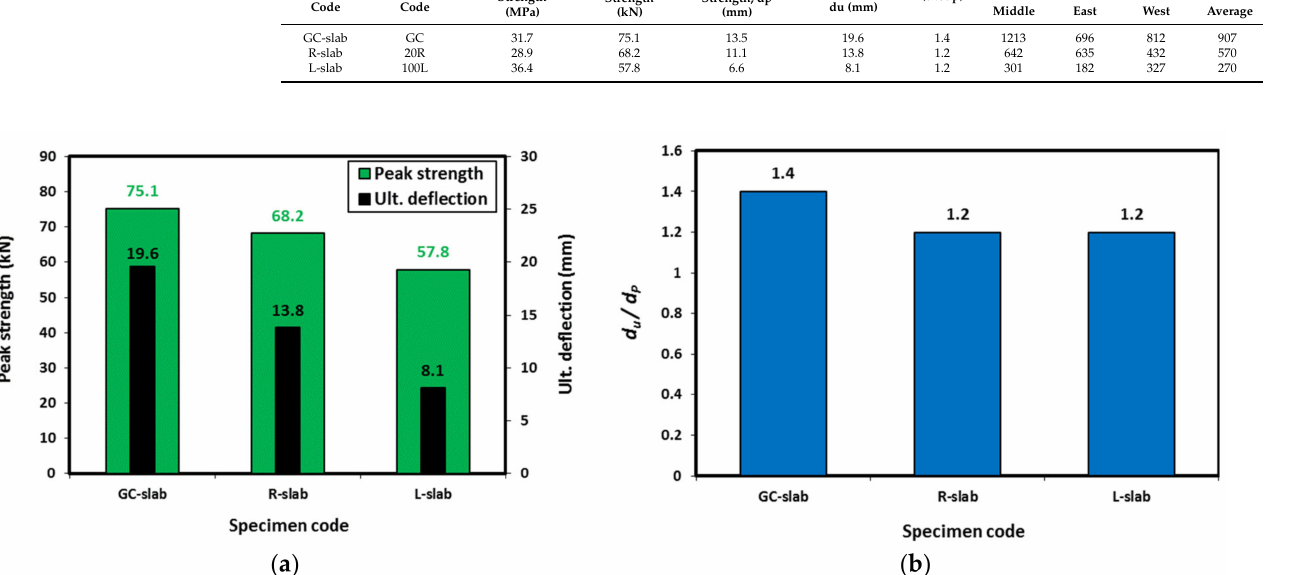
Figure 12. Results of the tested slabs: ( a ) peak strength and ultimate deflection, and ( b ) displacement